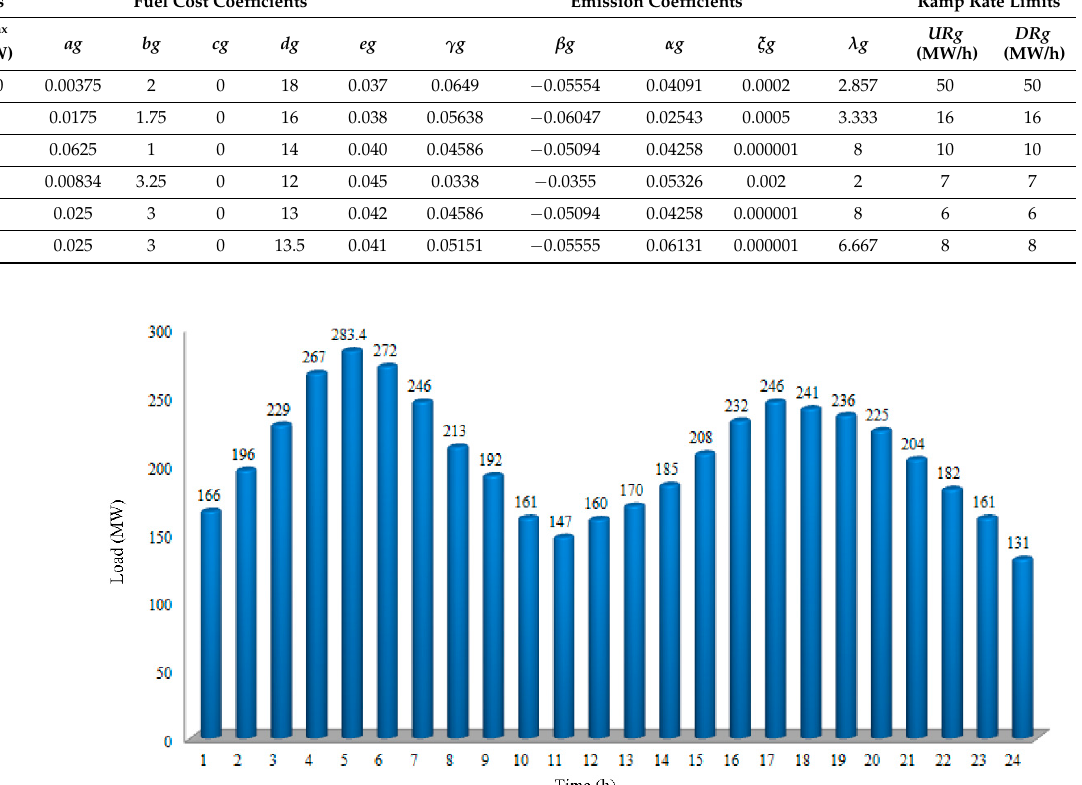
Figure 4. The load demand profile of 24 h from six test system units.